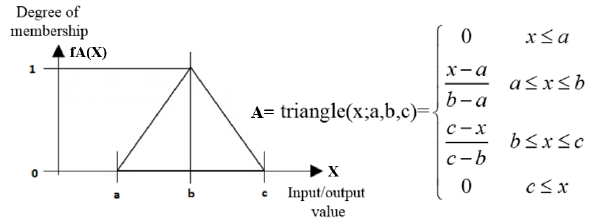
Figure 13. The membership functions for a generic variable.